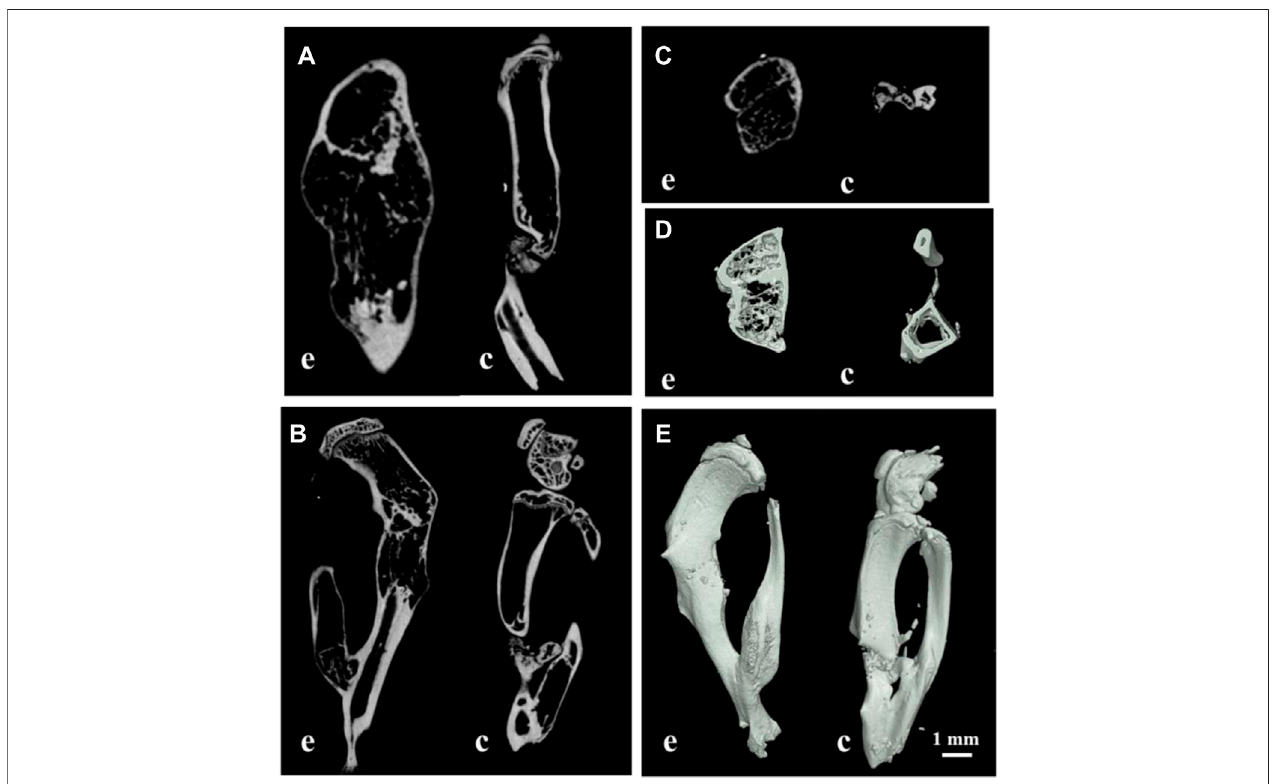
FIGURE6| Multi-viewofsagittal (A) ,transverse (B) ,coronal (C) ,andsectionalplanes (D), andthestereogram (E) ofmousetibiabymicro-CT; (E) theexperimental group; (C) the control group; bar: 1 mm.